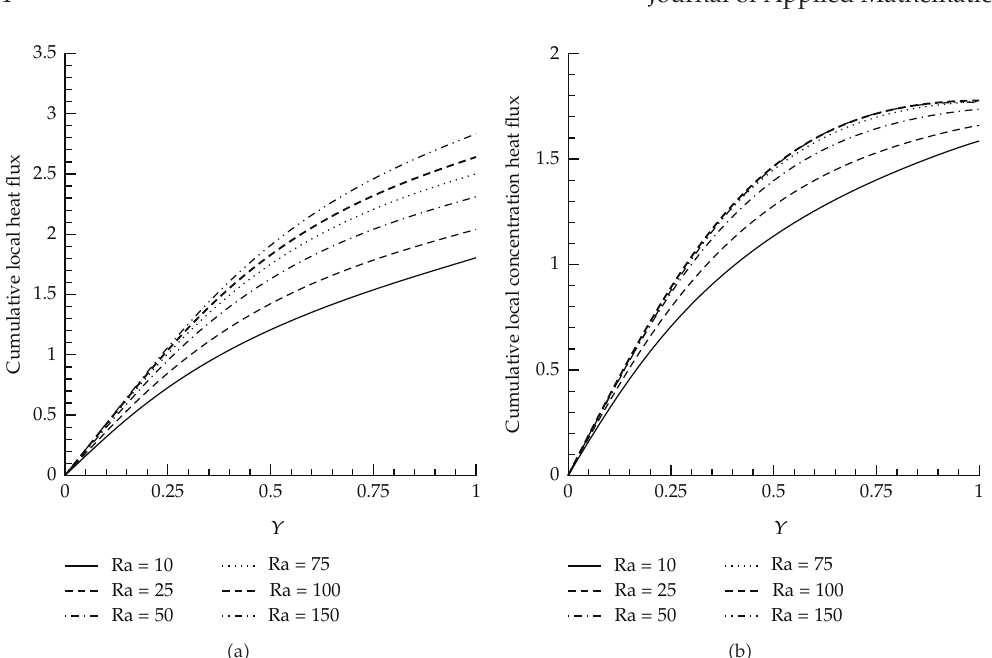
Figure 19: (cid:2) a (cid:3) Cumulative heat flux plots and (cid:2) b (cid:3) cumulative mass flux plots along the left vertical wall while fixing B (cid:8) 1, (cid:2) D/H (cid:3) (cid:8) 0 . 1, a (cid:8) 0 . 1, Le (cid:8) 1, S C (cid:8) 0 . 1 for di ff erent values of “Ra”.